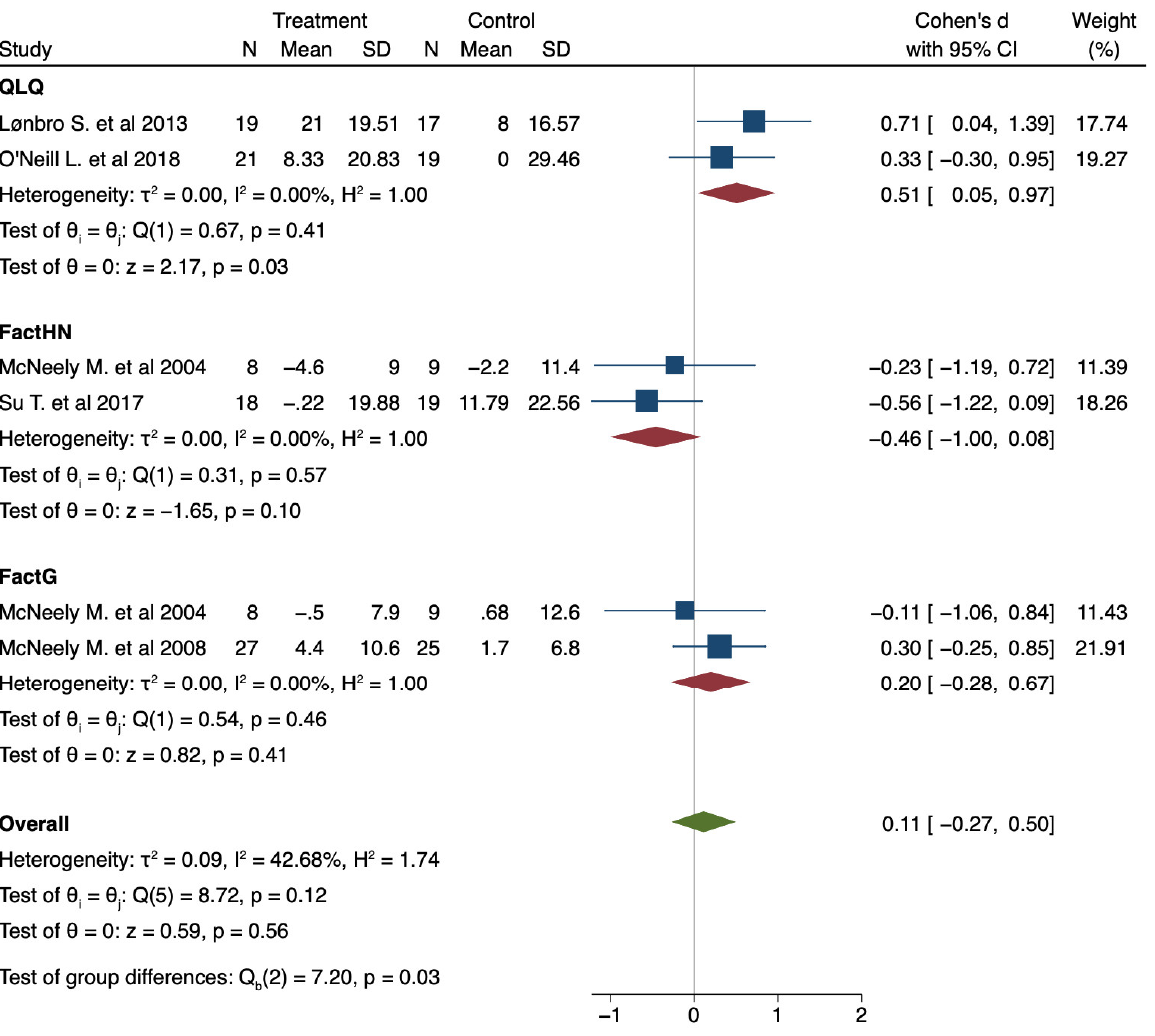
Figure 4. Forest plot presenting the effect of exercise on the improvement of Quality of Life (QoL) measured with different instruments in patients with Head and Neck cancer (HNC) compared with control; pre–post intervention data. Values on x-axis denote Cohen’s d. The diamond illustrates the 95% confidence interval of the pooled effects.